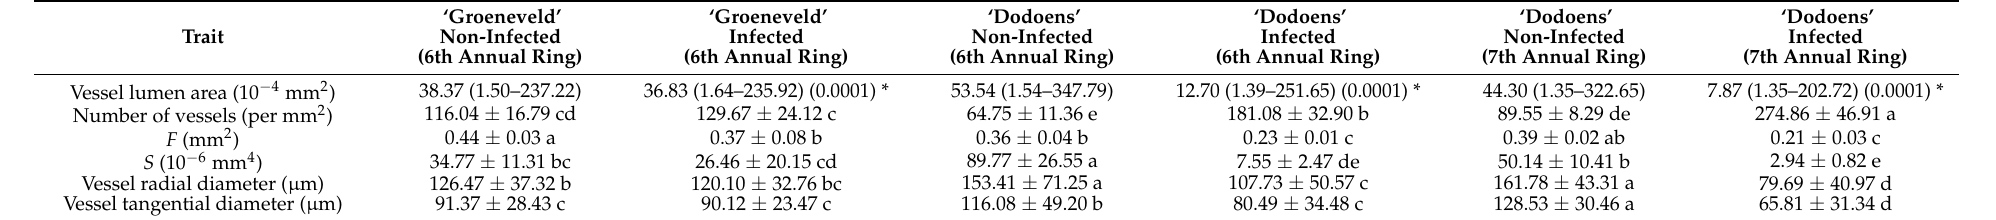
Table 1. Earlywood vascular anatomy in the examined Dutch elm hybrids.